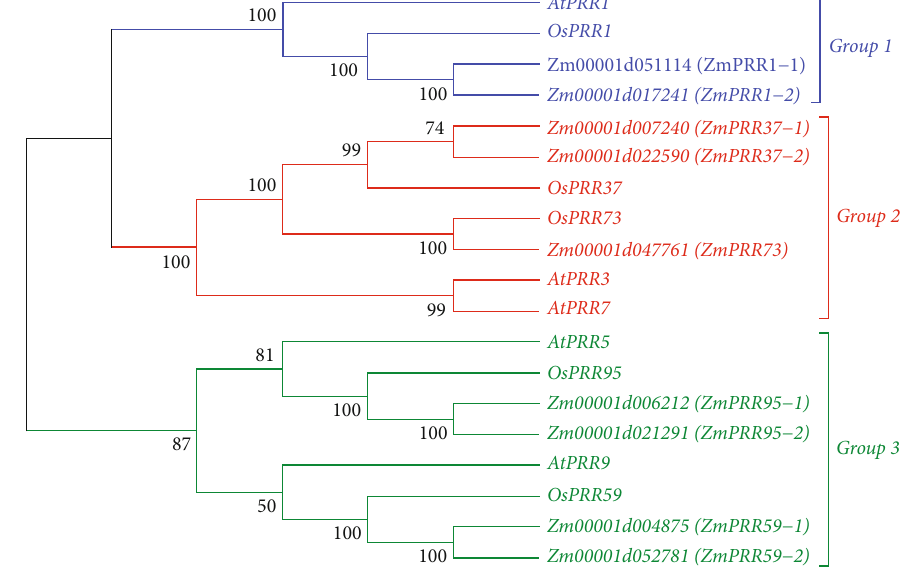
Figure 2: The phylogenetic tree of PRR proteins in maize, Arabidopsis , and